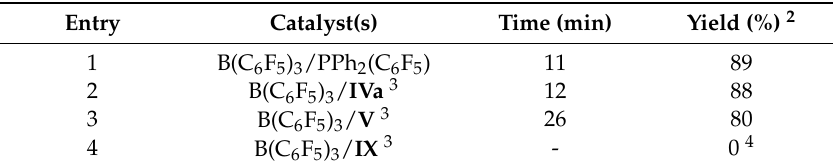
Table 2. Results for catalysis of the hydrosilylation reaction in Scheme 2 using the FLPs